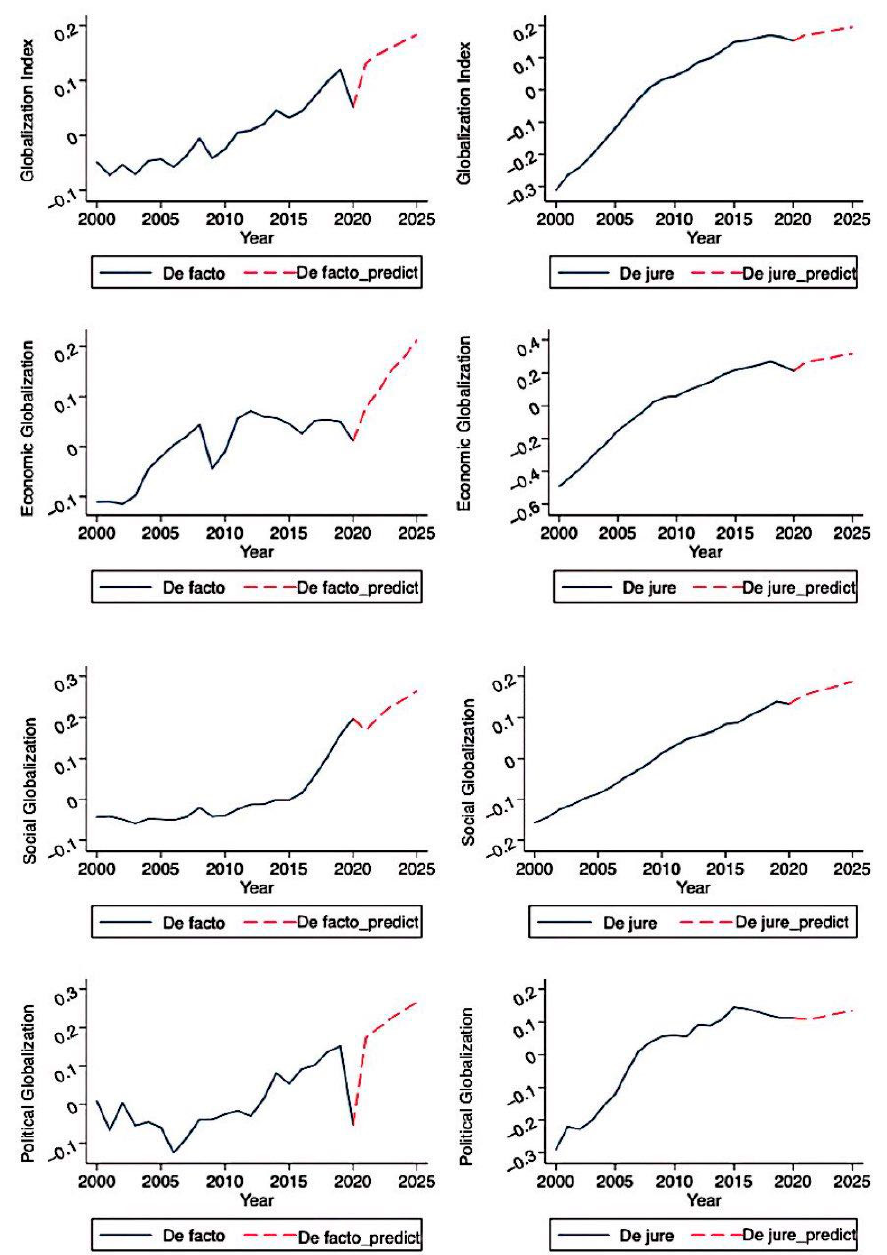
Figure 6. Forecasting of the globalization trends.